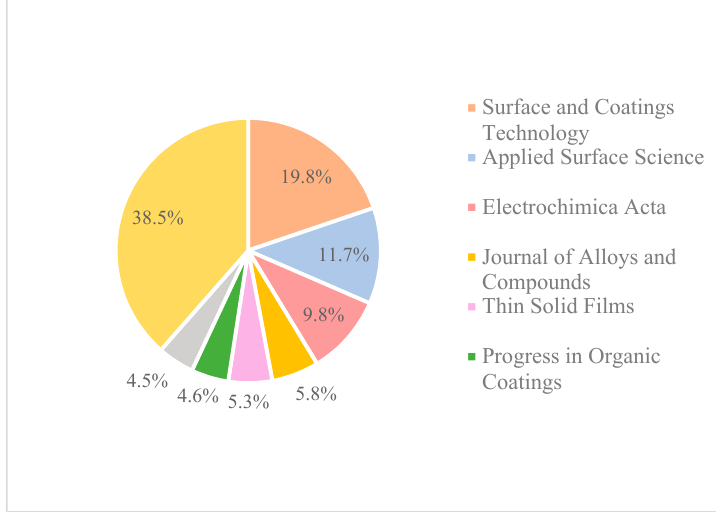
Figure 5. Distribution of published papers in nanocoating and corrosion among different journals.